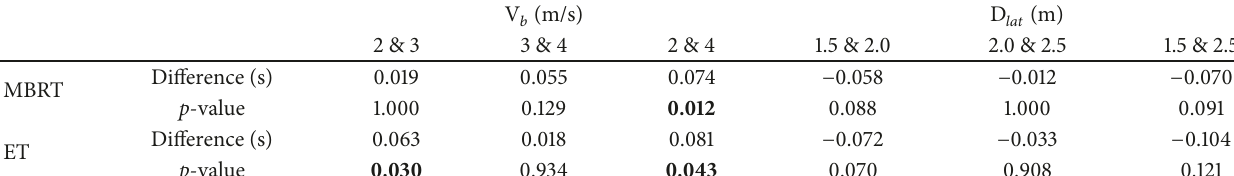
Table 10: Post hoc analysis for MBRT and ET in SCR.